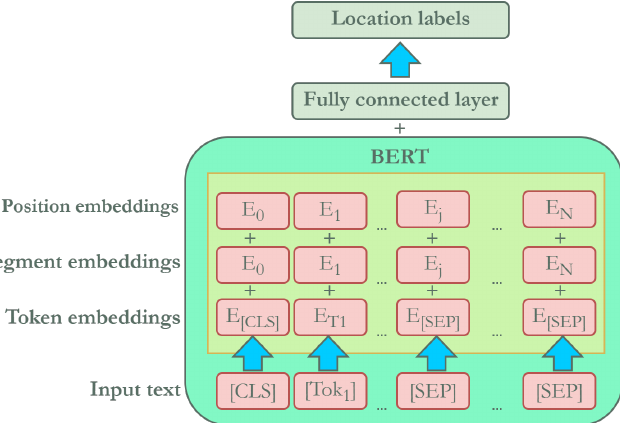
Figure 7. Illustration of BERT fine-tuning for location